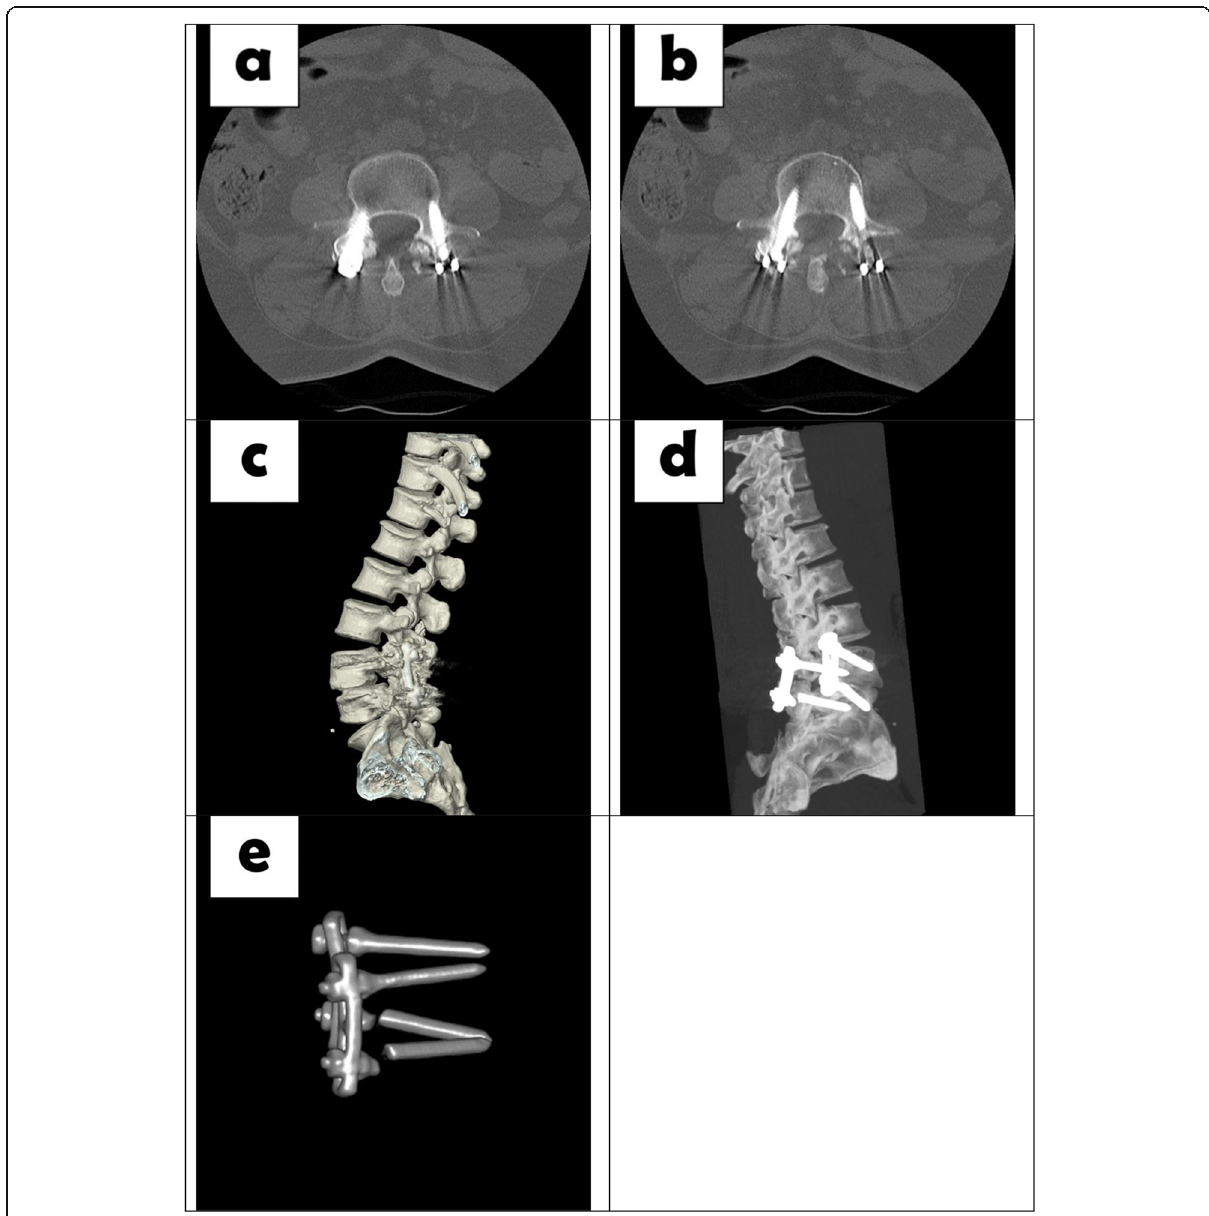
Fig. 2 Internal fixation of L4 and L5 vertebrae with plates and multiple screws. a , b Axial cuts are showing lateral violation of the screw in the left pedicle of L4 vertebrae (grade II) and medial deviation of the screw in the right pedicle (grade I). c – e 3D reconstruction sagittal cuts are showing grade I spondylolithesis at L4 and L5, with broken screws at level of L5